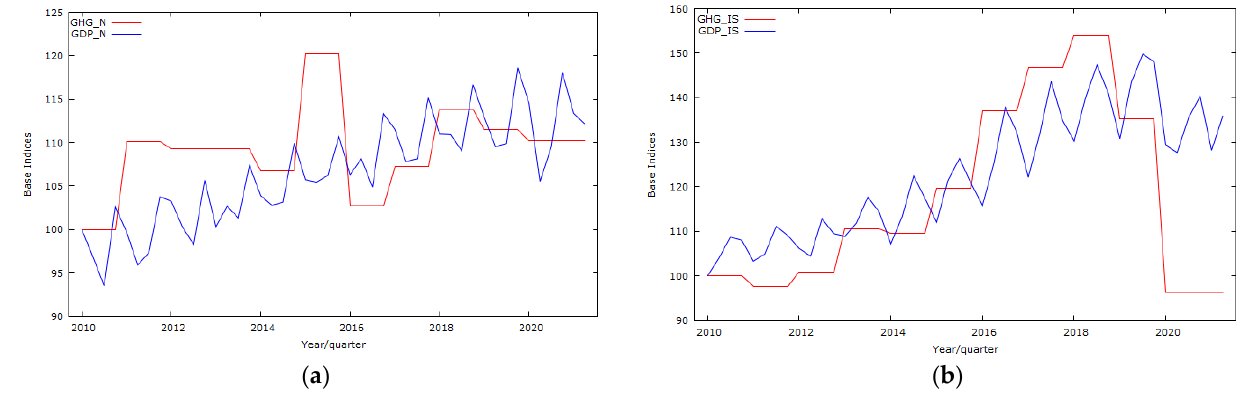
Figure 4. GDP over GHG: ( a ) Norway; ( b ) Iceland. Note: ln—natural logarithm, N—Norway, IS— Iceland, GDP—GDP at constant prices, and GHG—air emissions accounting for greenhouse gases. Source: Compiled by the authors, based on Eurostat (2022).